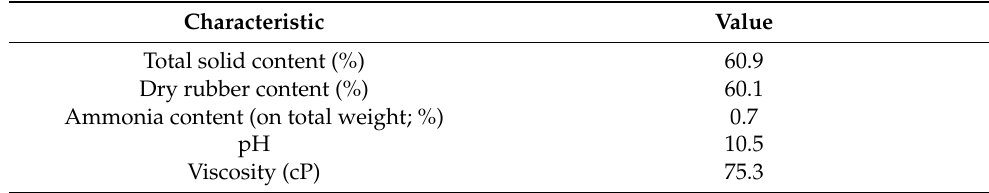
Table 1. Important characteristics of high-ammonia natural rubber latex (NRL) used in this work.